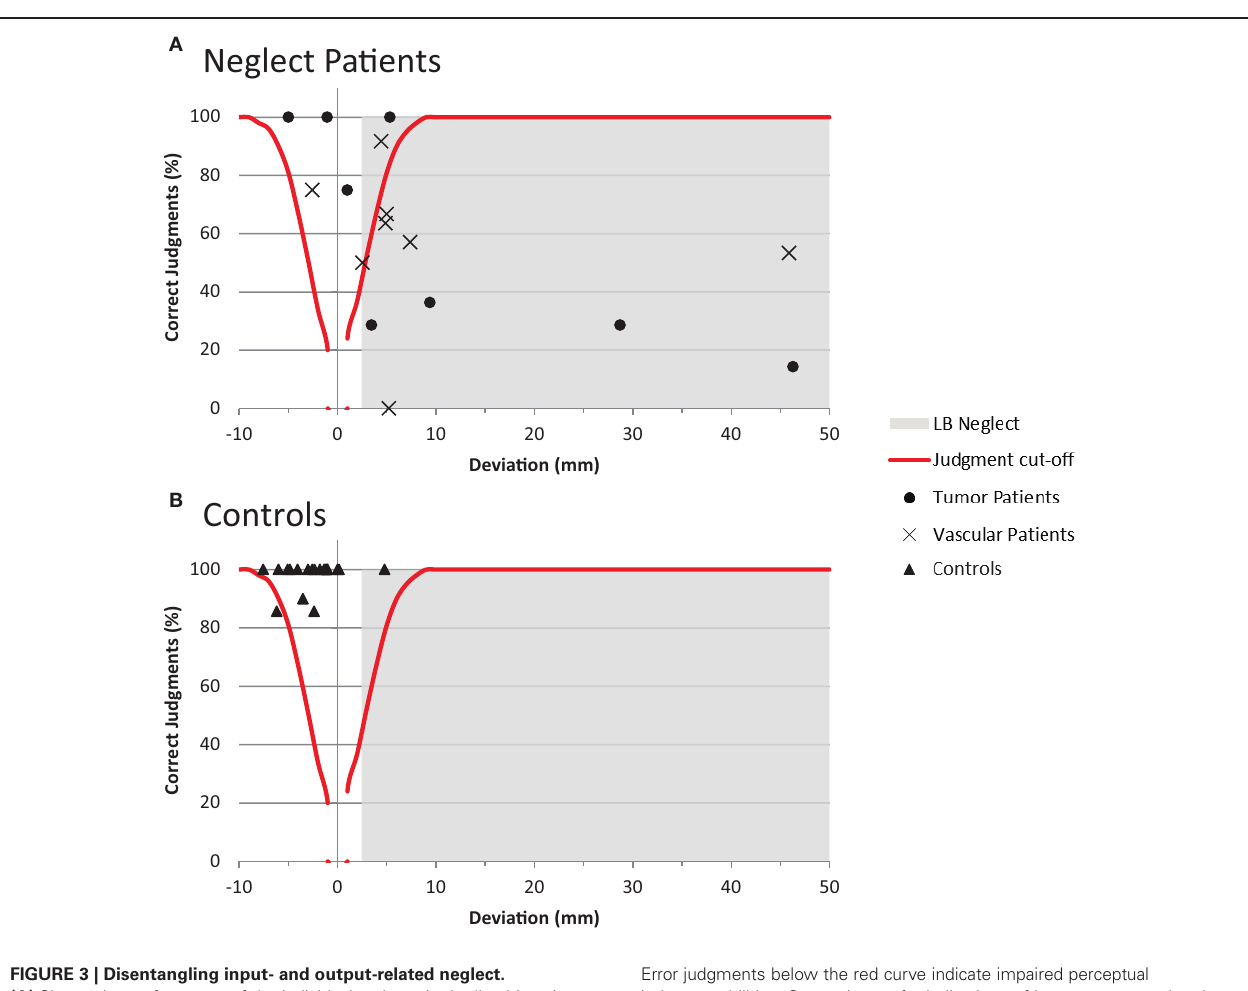
FIGURE 3 | Disentangling input- and output-related neglect. (A) Shows the performance of the individual patients in the line bisection and error judgment task (split by etiology). Bisection values in the gray colored area indicate the presence of neglect in the line bisection task.